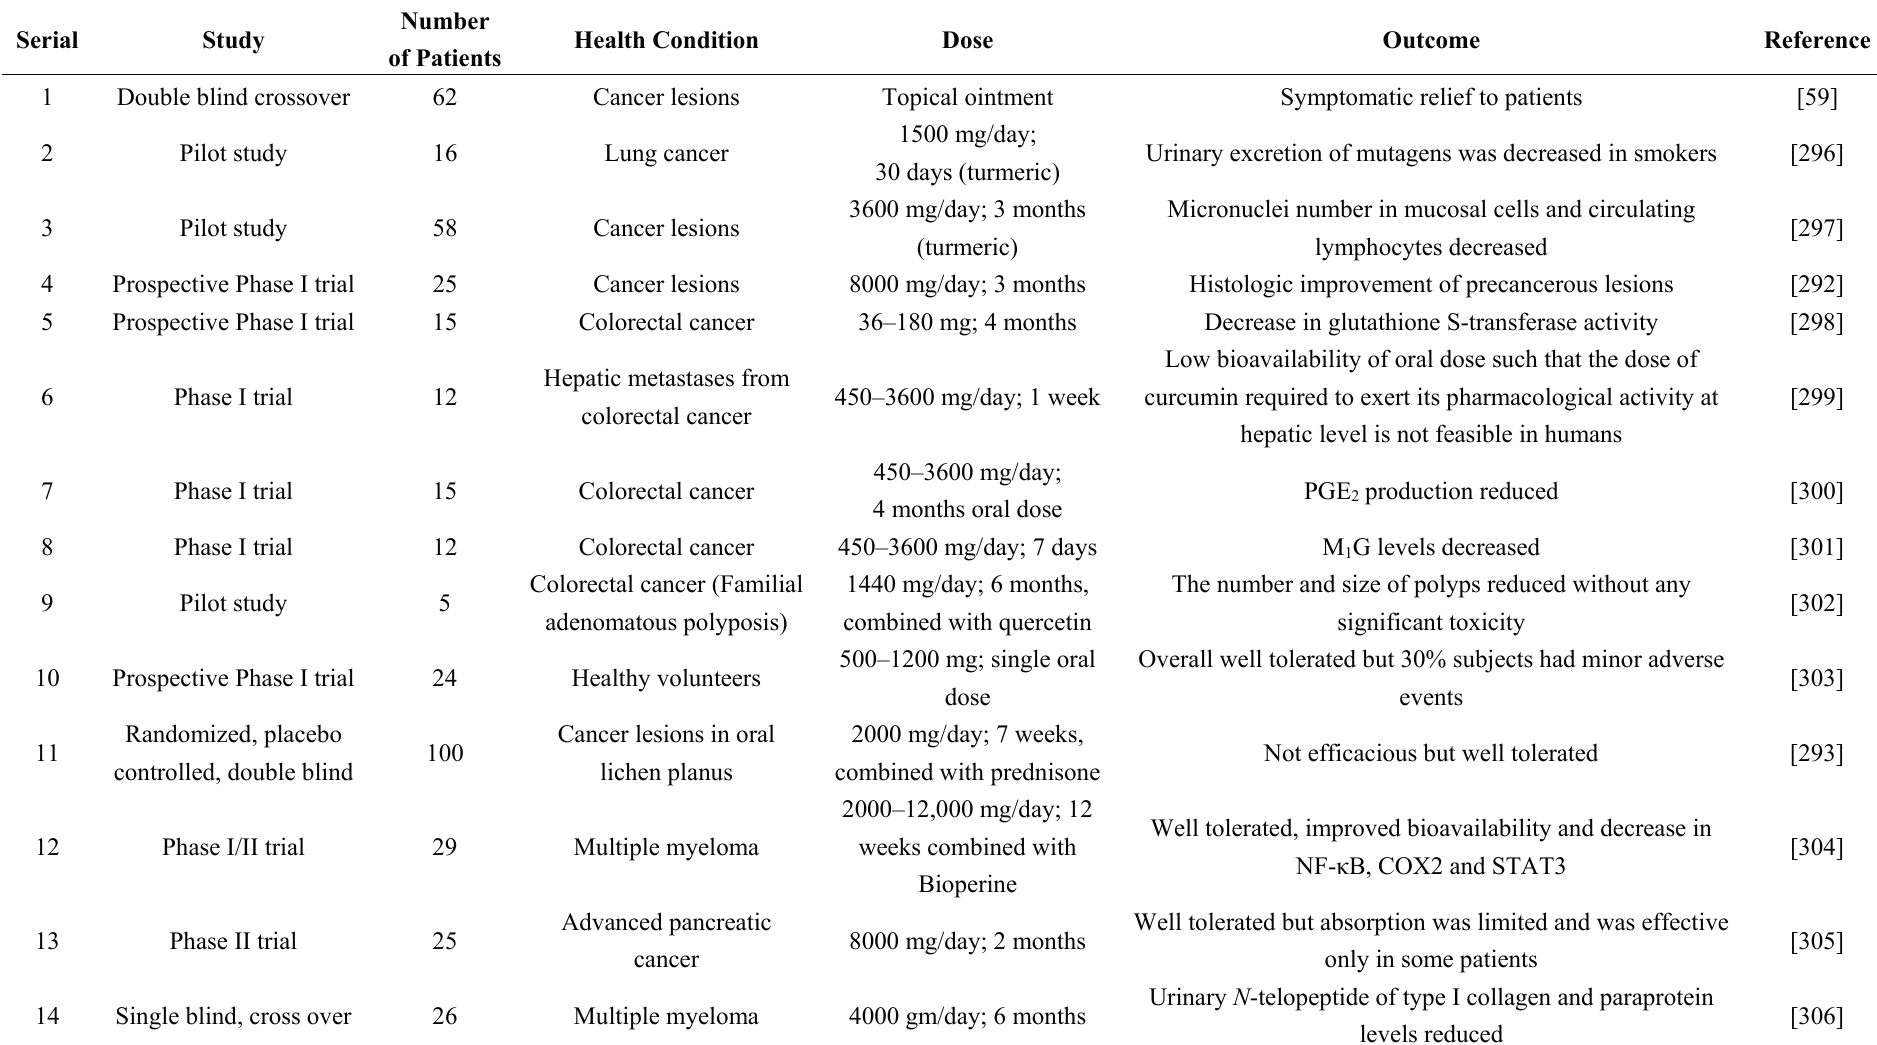
Table 1. Summary of clinical trials with curcumin in various